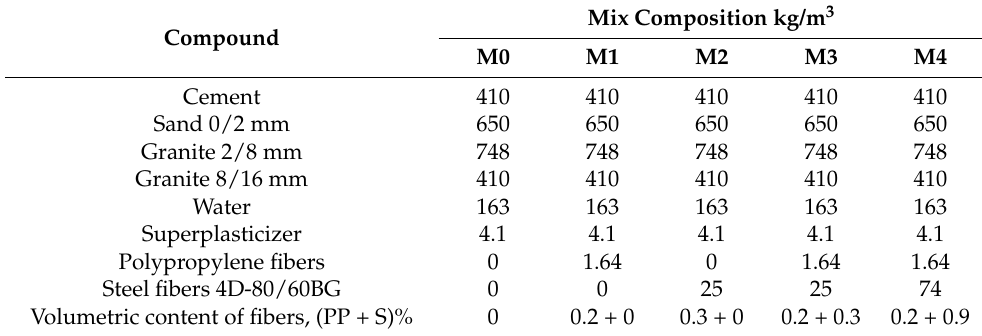
Table 2. Mix compositions of all tested materials including the volumetric content of